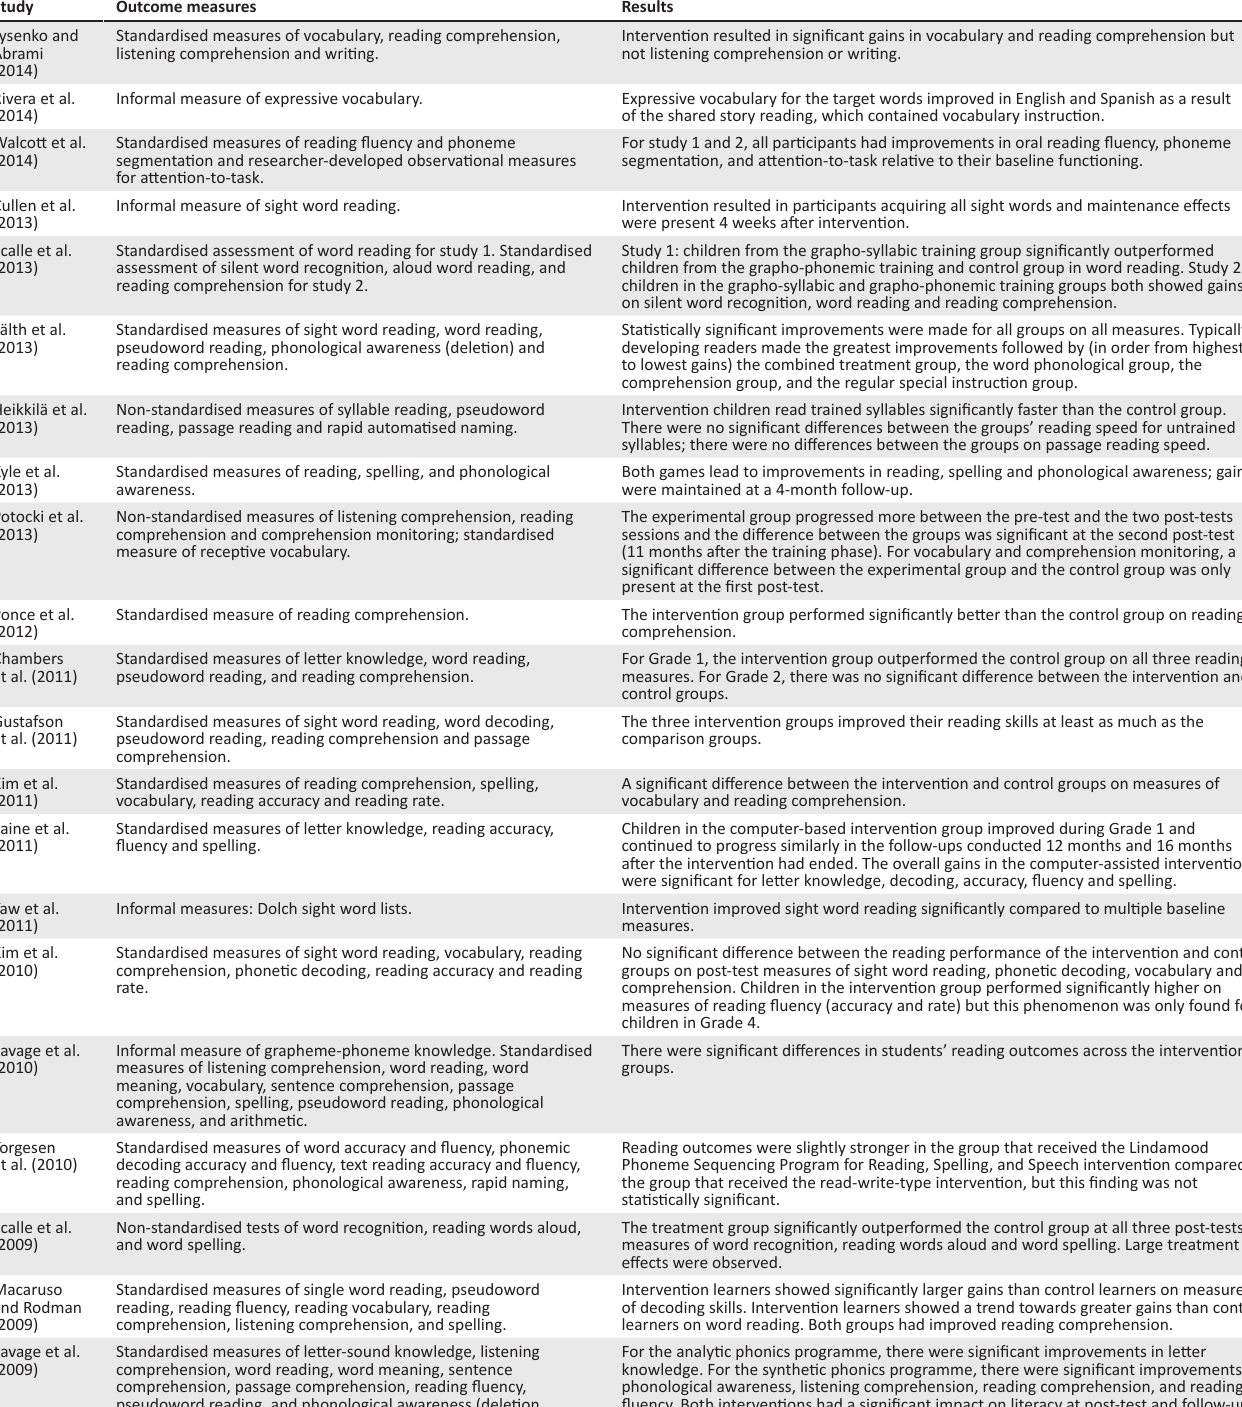
TABLE 3-A1 (Continues...): Outcome measures and results of the studies included in the information and communication technology-based reading intervention literature review. Study Outcome measures